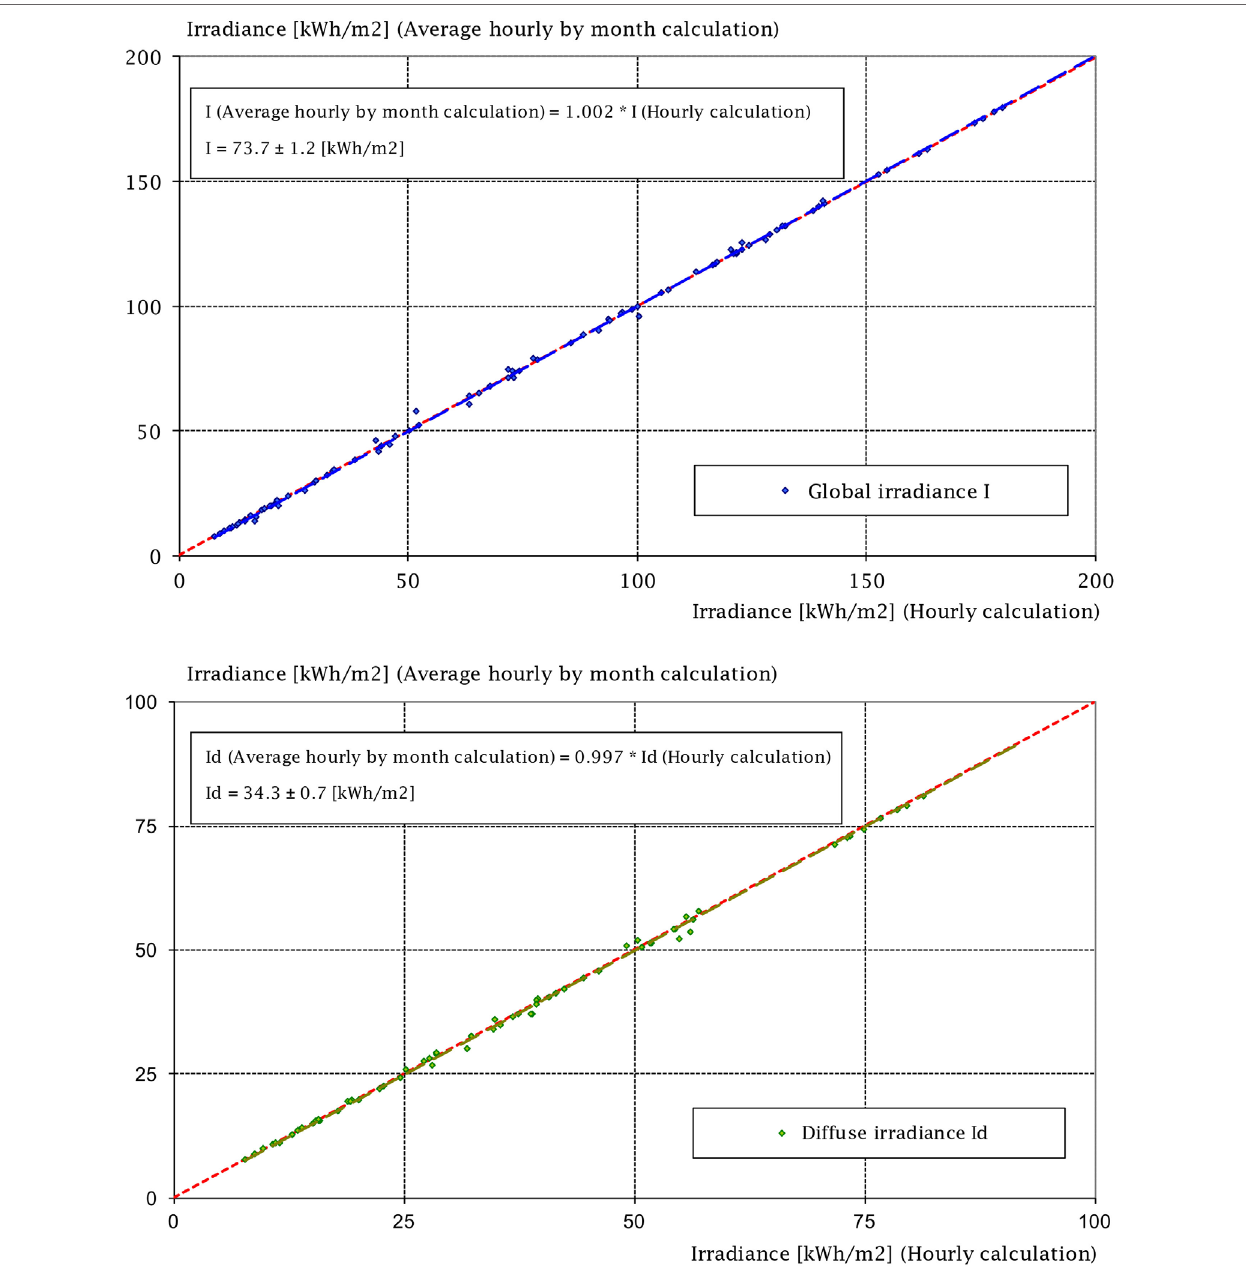
FIGURe 13 | Comparison of results obtained by the UNIGE’s on all studied points with real hourly and average hourly by month irradiance values, on a monthly base and distinguishing global (top) and diffuse (bottom) components. Reproduced from Ineichen (2012). No permission is required from the copyright holder for the use of this image in this